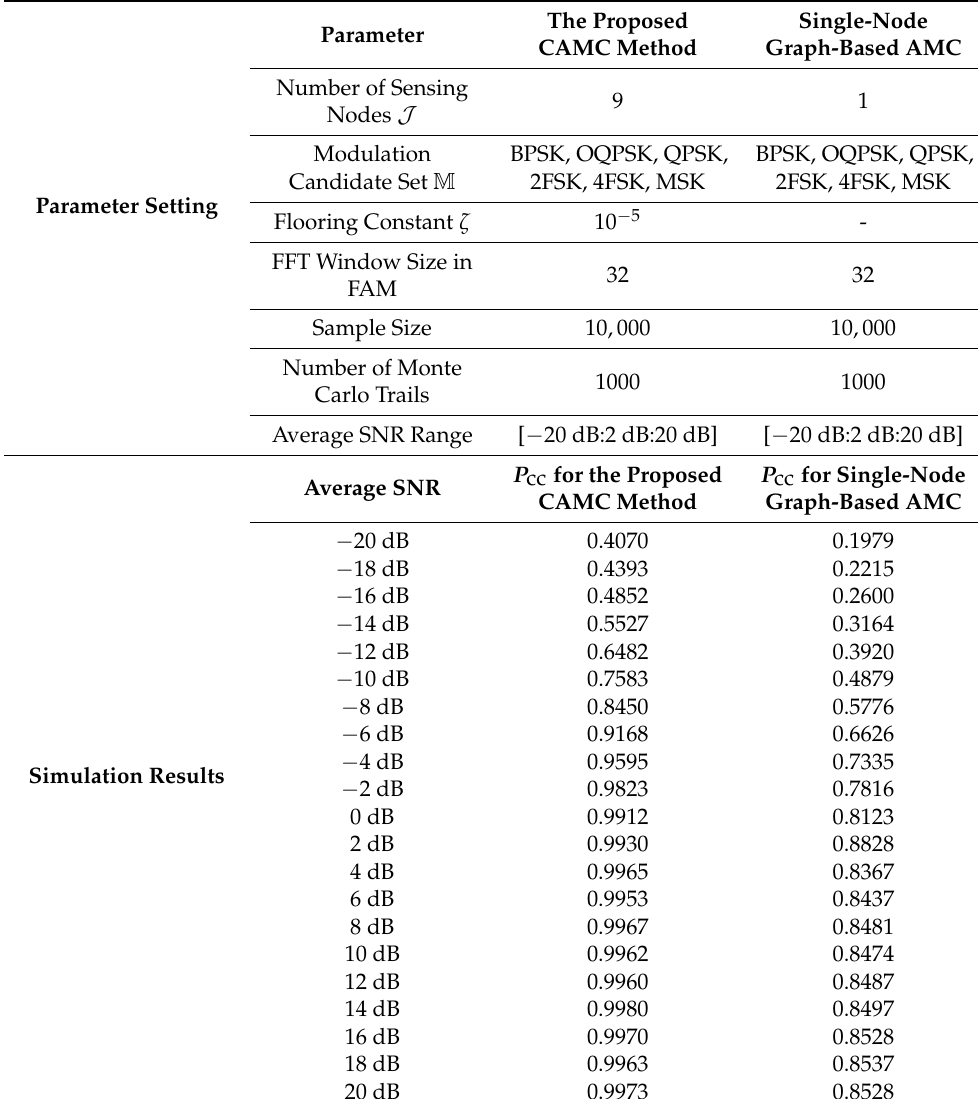
Table 6. The parameter setting and the P cc’s of our proposed CAMC approach and the existing single-node graph-based AMC method in